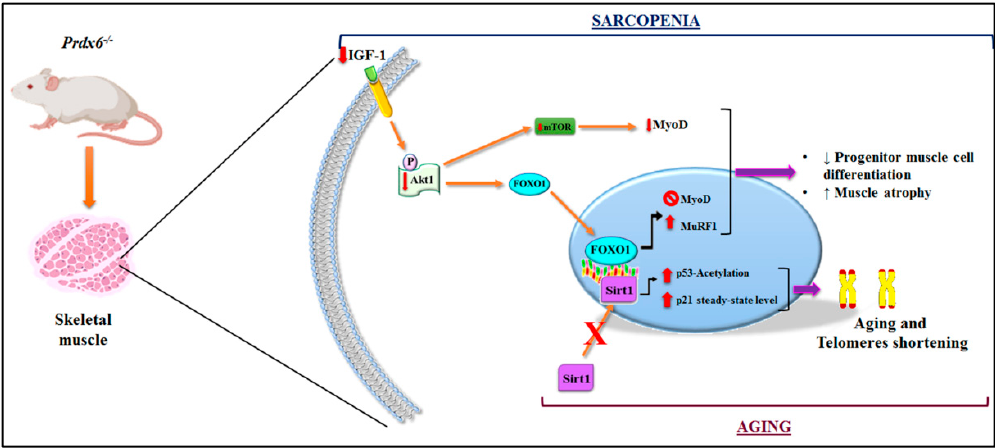
Figure 7. Graphical representation of Prdx6 in the regulation of mechanism related to aging and sarcopenia. In skeletal muscle of Prdx6 - / - mice, the related impairment in muscle mass turnover depending on the alteration of IGF-1 / Akt-1 / mTOR / FOXO1 signaling pathway has been described. Moreover, the inhibition of SIRT1 nuclear translocation and activation with subsequent reduction in telomeres length and the activation of the p53 / p21 pro-aging pathway has been detected. The illustration was performed by using Bio Render and Photoshop programs.